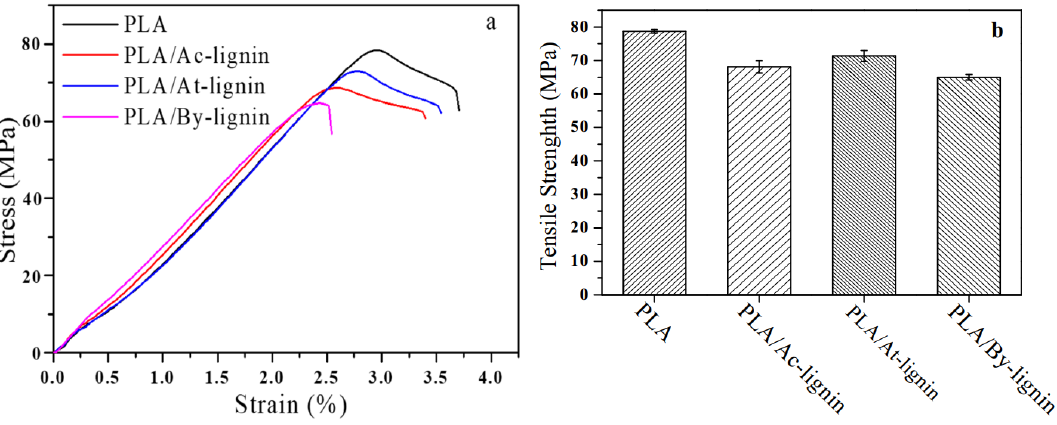
Figure 4. Tensile stress – strain curves ( a ) and tensile strength statistical histogram ( b ) of pure PLA and PLA/lignin biocomposites. Reproduced from [43], with the permission of